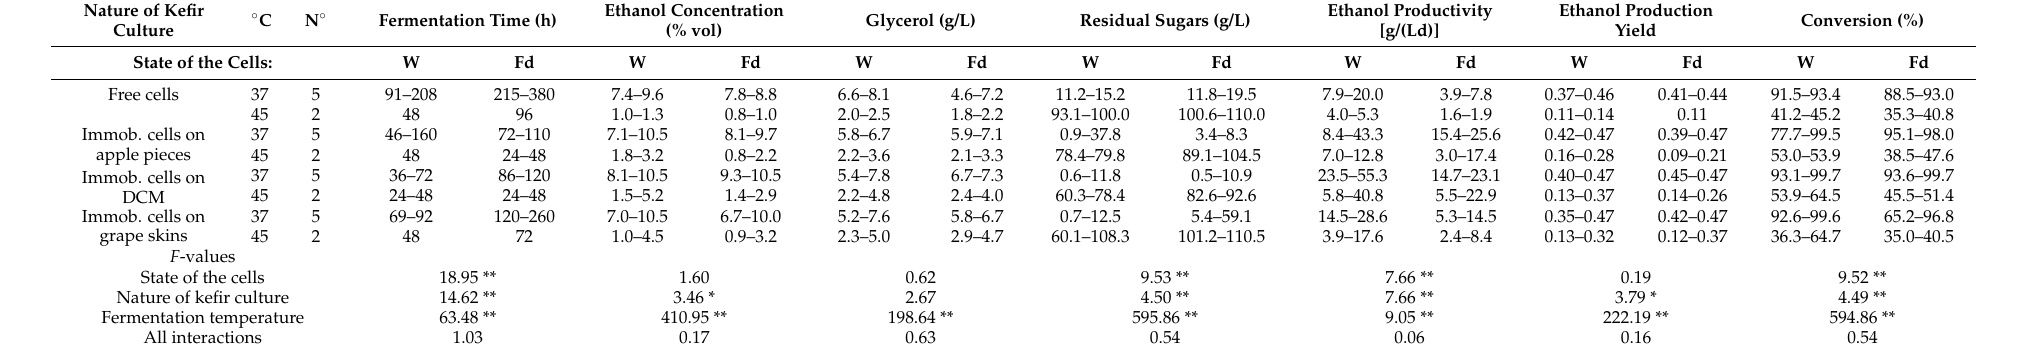
Table 1. Effect of cell immobilization, freeze-drying, and high temperature on kinetic parameters during semi-dry and sweet low alcohol wine-making by repeated batch fermentations using kefir culture.